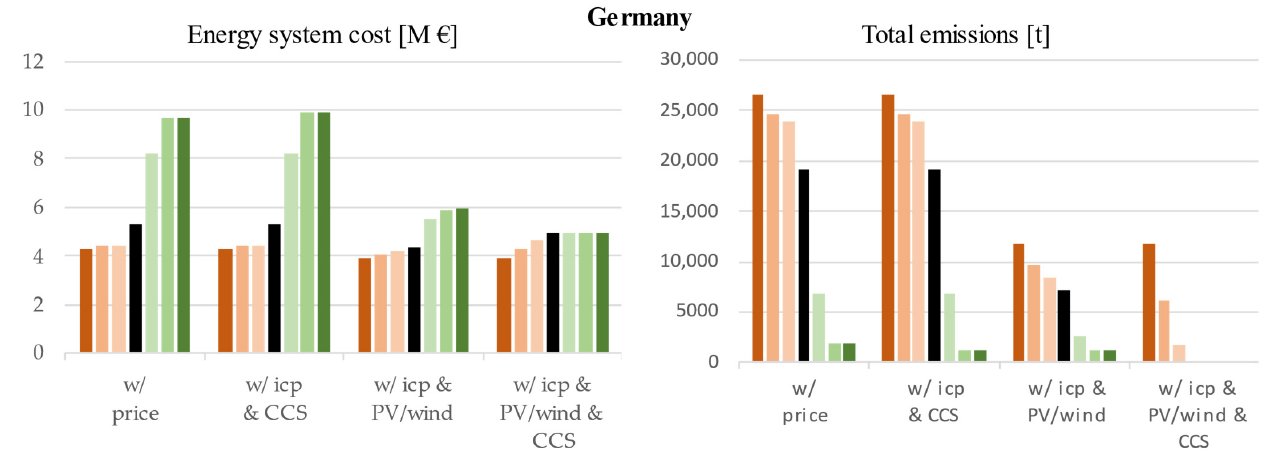
Figure 11. Sensitivity analysis results for the German scenarios.